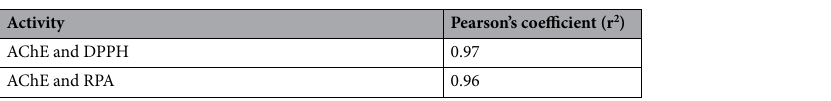
Table 3. Correlation analysis using Pearson’s coefficient of correlation. AChE acetylcholinesterase inhibitory, DPPH 2,2-diphenyl-1-picryl-hydrazyl-hydrate, RPA reducing power assay.